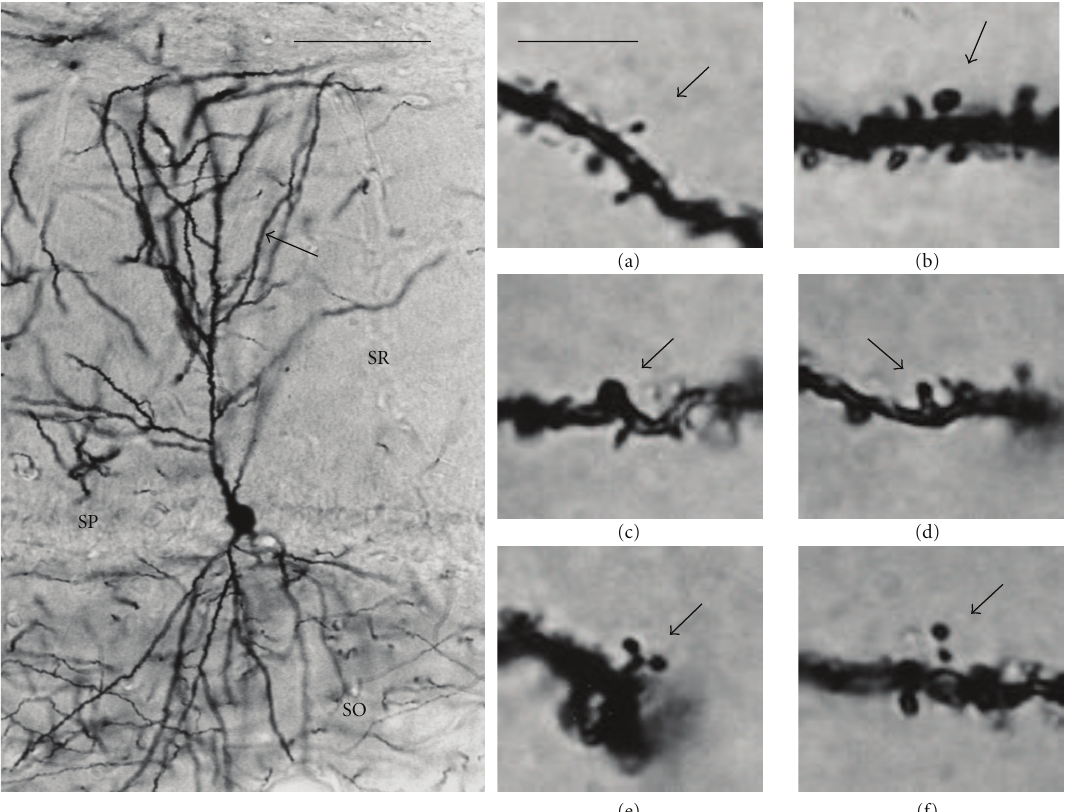
Figure 1: Examples of dendritic spines stained with the Golgi method. Left panel: photomicrograph of a CA1 pyramidal neuron impregnated with a modification of the Golgi method. Spines studied in the present work were counted in a segment 50 μ m in length of a secondary dendrite (arrow) protruding from its parent apical dendrite. SO: stratum oriens; SP: stratum pyramidale; SR: stratum radiatum. Scale bar = 100 μ m. In the right panels, photomicrographs show representative examples of thin (a), mushroom (b), stubby (c), wide (d), branched (e), and double (f) spines (arrows). Scale bar = 5 μ